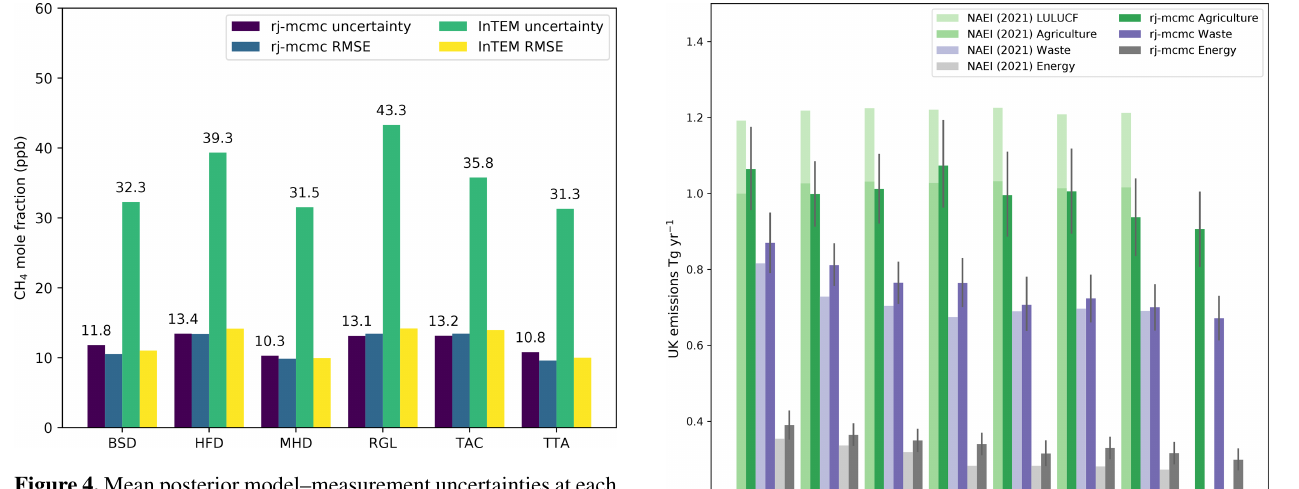
Figure 4. Mean posterior model–measurement uncertainties at each site from the rj-mcmc inversions and prescribed uncertainties in the InTEM inversions. Also shown are the mean posterior root mean square errors (RMSE) from the respective inversions. BSD – Bils- dale; HFD – Heathfield; MHD – Mace Head; RGL – Ridge Hill; TAC – Tacolneston; TTA – Angus.